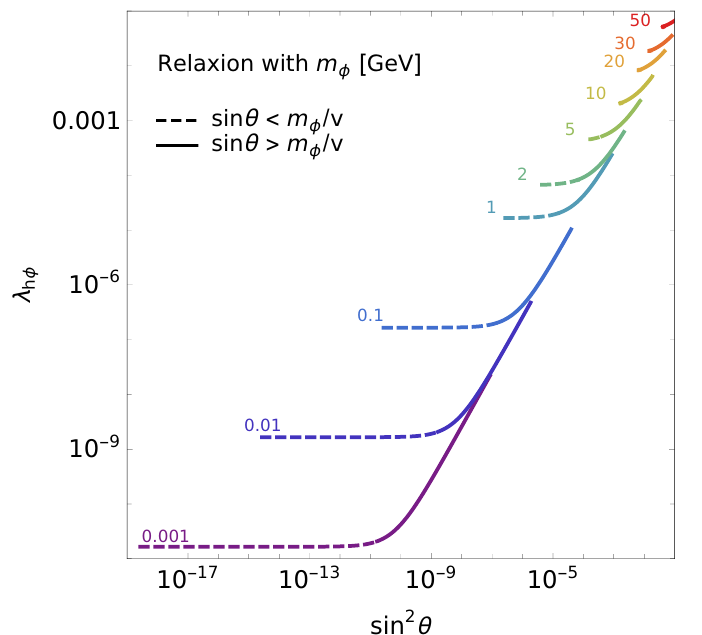
Figure 1 . Natural relaxion parameter space in the sin 2 θ - λ hφ plane. Each color shows one mass given in GeV. The dashed (solid) part of the lines corresponds to sin 2 θ < ( > ) m 2 mixing angle of the renormalizable singlet is natural (unnatural). The plotted λ relaxion is defined in eq. (2.33), within the natural sin 2 θ range from section